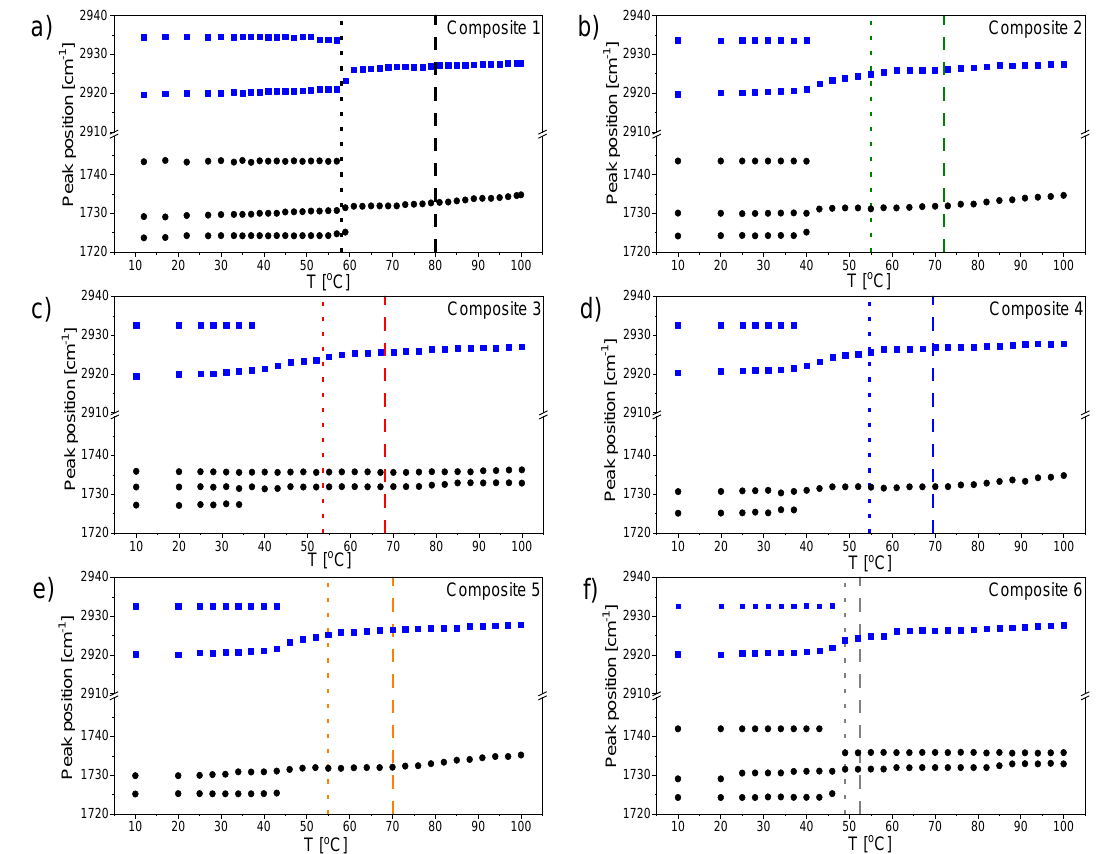
Figure 21. Temperature dependencies of the peak maximum position of two IR bands connected to ν(C=O) (black circles) and ν as (CH 2 ) (blue squares) modes obtained for pure EHPDB — Composite 1 ( a ), Composite 2 ( b ), Composite 3 ( c ), Composite 4 ( d ), Composite 5 ( e ), and Composite 6 ( f ) during cooling from the isotropic phase. The vertical dashed and dotted lines represent the SmA* – SmC* and SmC* – Cr 1 phase transition temperatures obtained during cooling by DSC, respectively. The thermal behavior of the ν as (CH 2 ) band was identical for all six systems. At 100 ◦ C, it appeared at about 2928 cm − 1 , which proved that a highly disordered ’liquidlike’